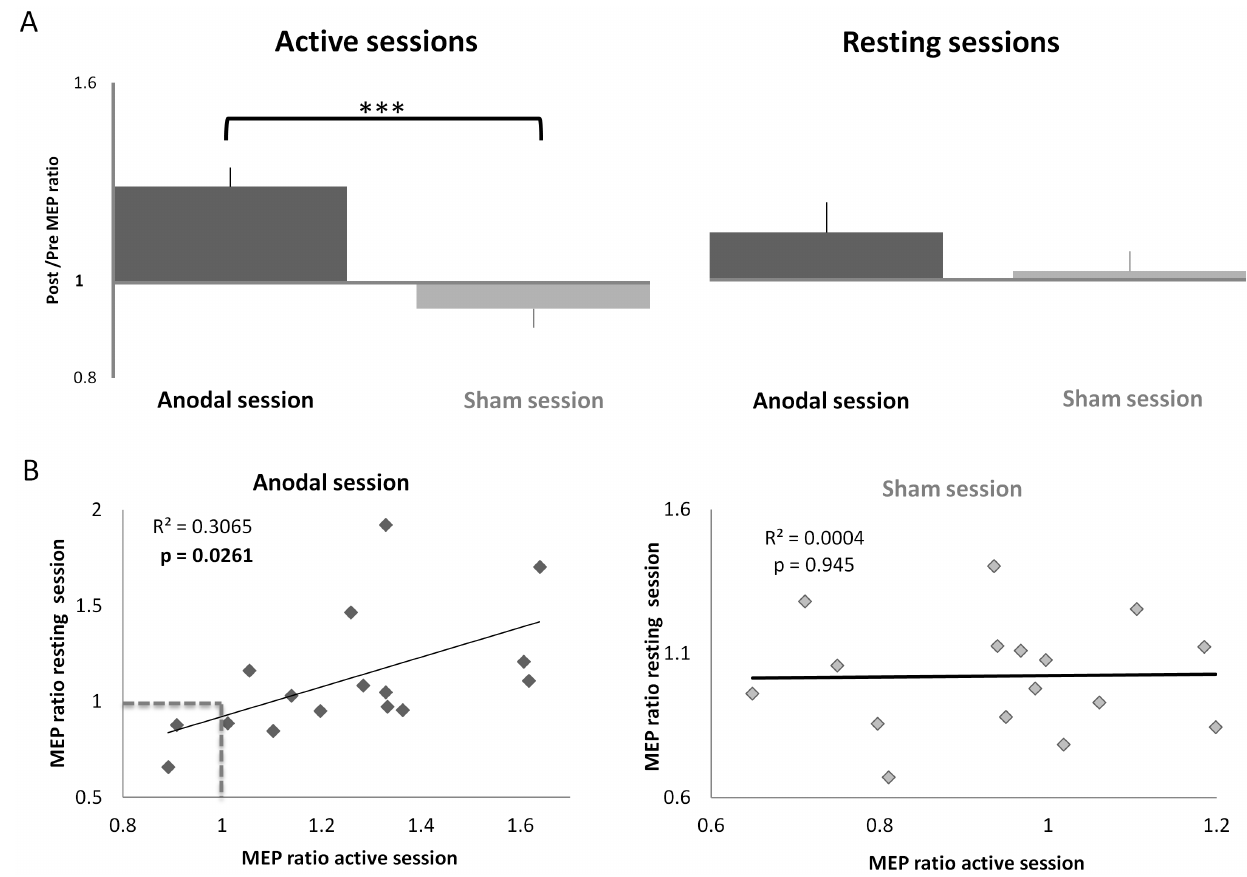
Figure 3. Corticomotor excitability results. A : MEP amplitude increased following the application of anodal tDCS in both active and resting motor states when compared to sham. The increase was only significant (p , 0.001) in the active session. B : The MEP amplitude increase observed in the active and resting anodal sessions was significantly correlated (p=0.026). This was not the case for the sham sessions. Data points to the left of and below the dotted lines (i.e. MEP ratio , 1) indicate participants who did not increase excitability in either of the anodal sessions. Error bars represent mean 6 SEM. *** p , 0.001 doi:10.1371/journal.pone.0101496.g003 PLOS ONE |